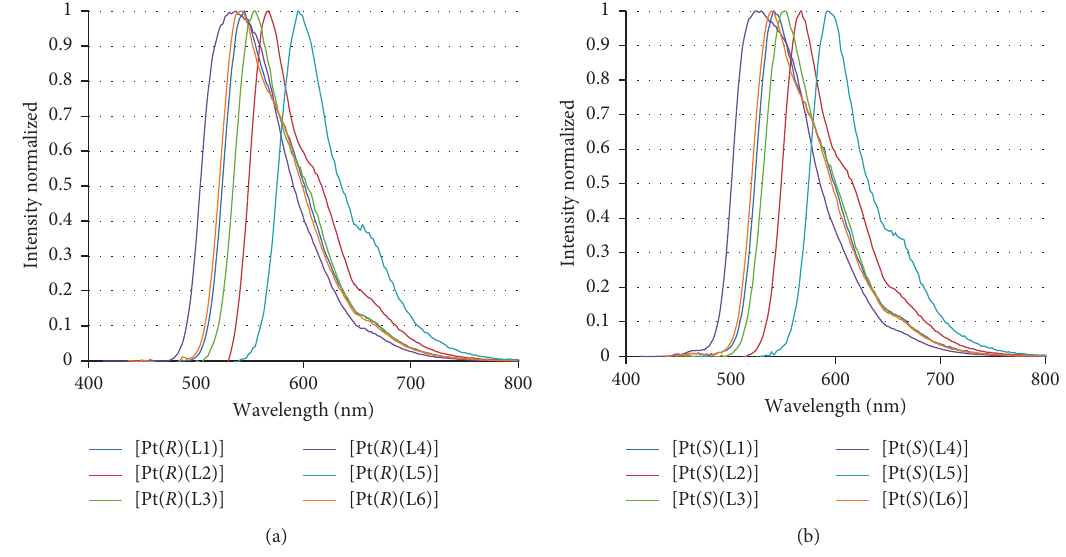
Figure 4: Emission spectra of chiral salen Pt(II)